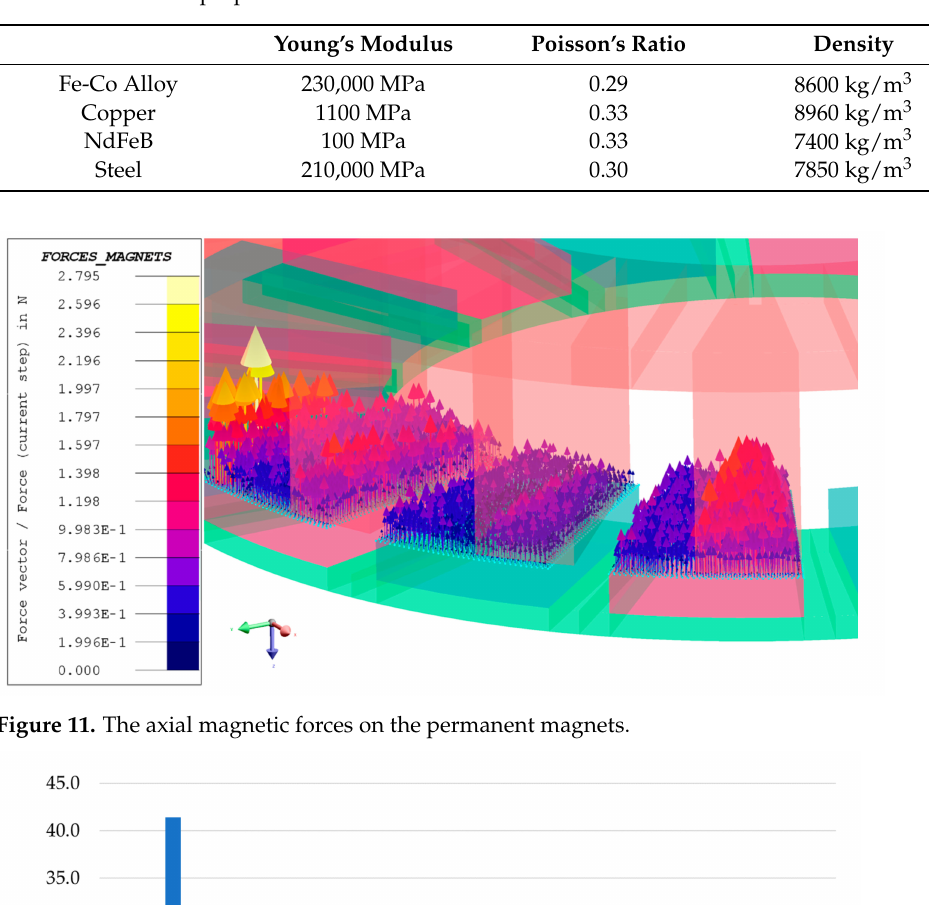
Table 5. Mechanical properties of the chosen materials.